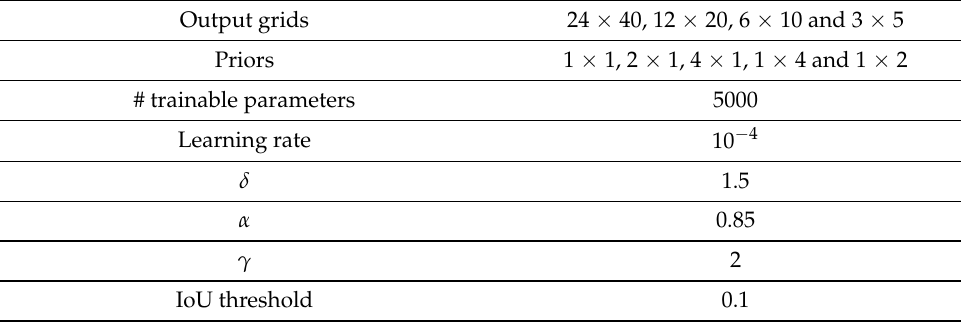
Table 1. Parameters and properties of the adopted SSD.